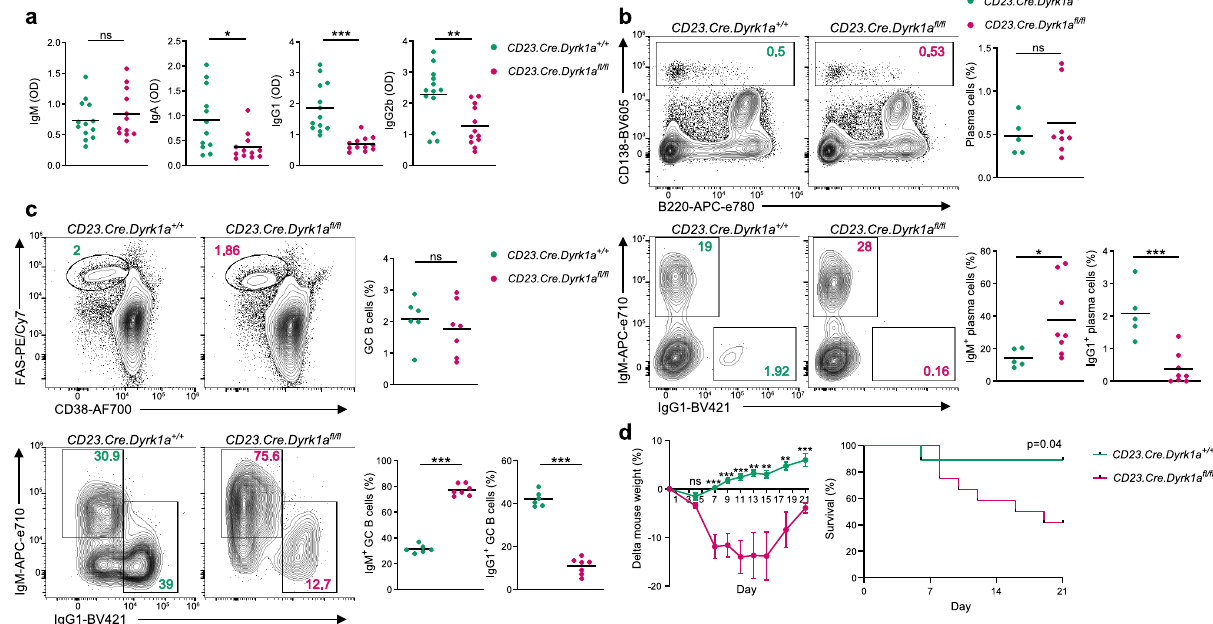
Fig.3|B-cellclassswitchrecombinationinvivorequiresDYRK1A.a SerumIgM, IgA, IgG1, and IgG2b titers as determined by ELISA ( n =12 – 13 unmanipulated mice; two independent experiments, two-tailed Student ’ s t test). b Representative fl ow cytometry plots and frequencies of total and IgG1 + BM PCs in unmanipulated mice ( n =5 – 8; three independent experiments, two-tailed Student ’ s t test). c Representative fl ow cytometry plots and frequencies of total GC and isotype-